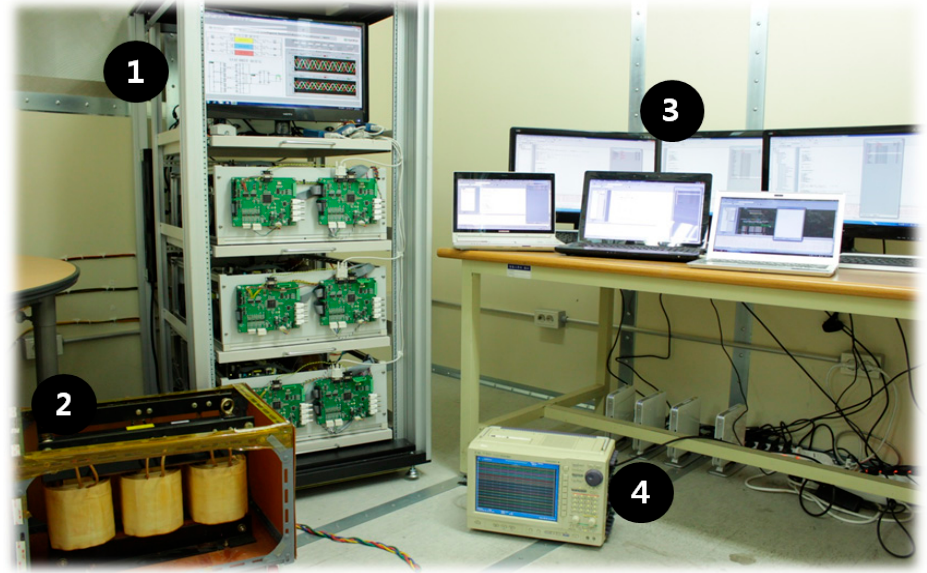
Figure 11. Experimental set ‐ up for 3 ‐ phase hardware prototype.